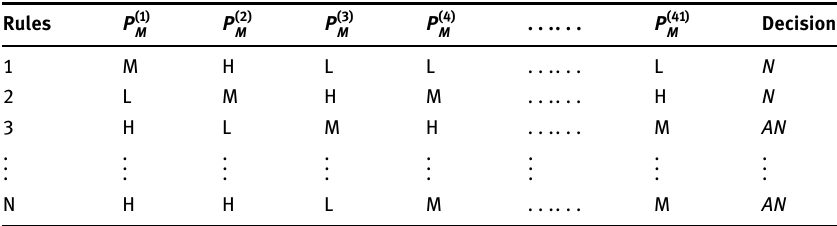
Table 3: Sample Rules are Fuzzy